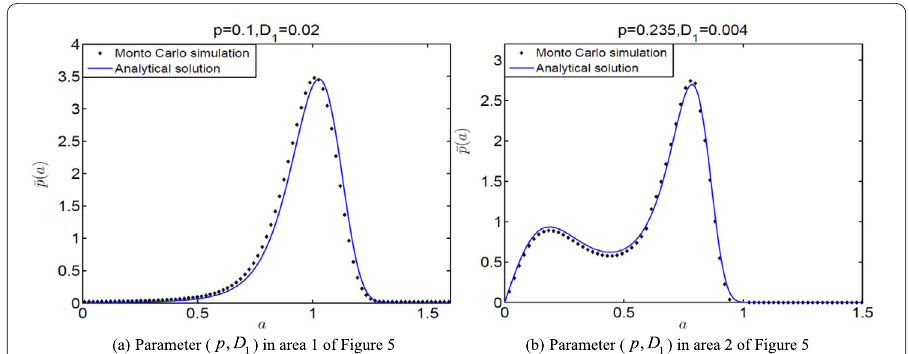
Figure 6 PDFs for ¯ p ( a ) under additive noise excitation (taking p and D 1 as unfolding parameters)